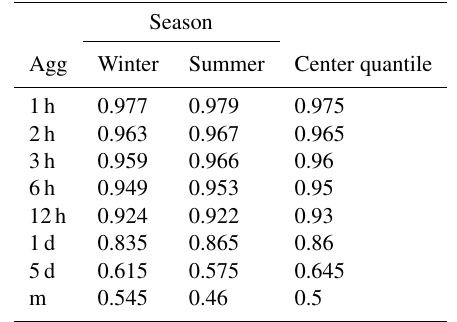
Table 2. The control quantiles ( Q c ) that exhibit the highest mean pairwise rank correlations with the other quantiles. They are shown for different temporal aggregations (agg) and separately for summer and winter. Additionally, the (center) quantile in the middle of the investigated quantile range is